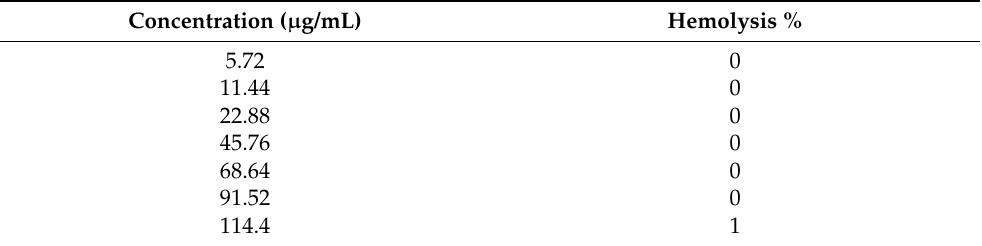
Table 2. Hemolytic activity of alapropoginine against human erythrocytes after 60 minutes’ incubation. The results were recorded at λ = 450 nm.